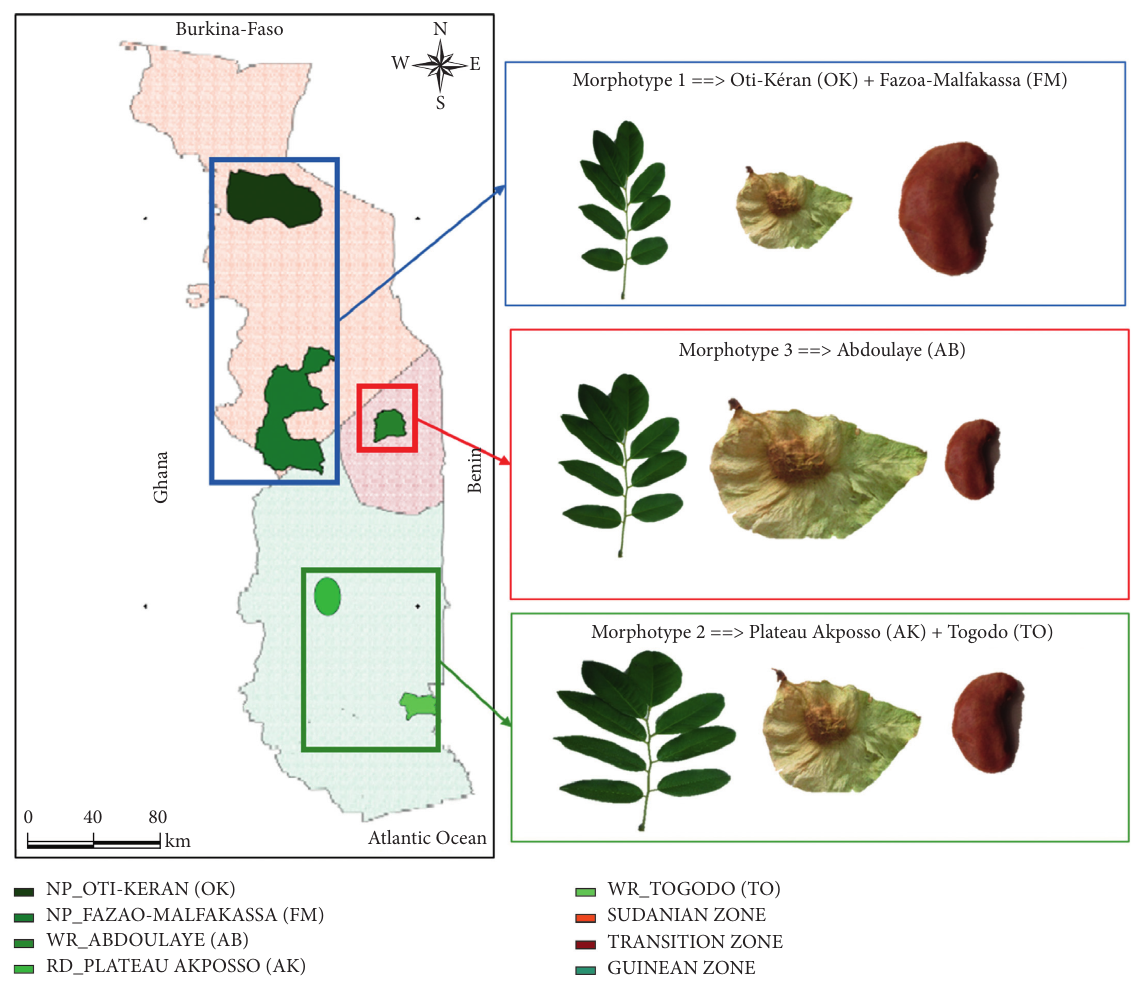
Figure 12: Pterocarpus erinaceus’ populations identified in Togo. Table 14: Mean values of the groups’ characteristics obtained through the digital